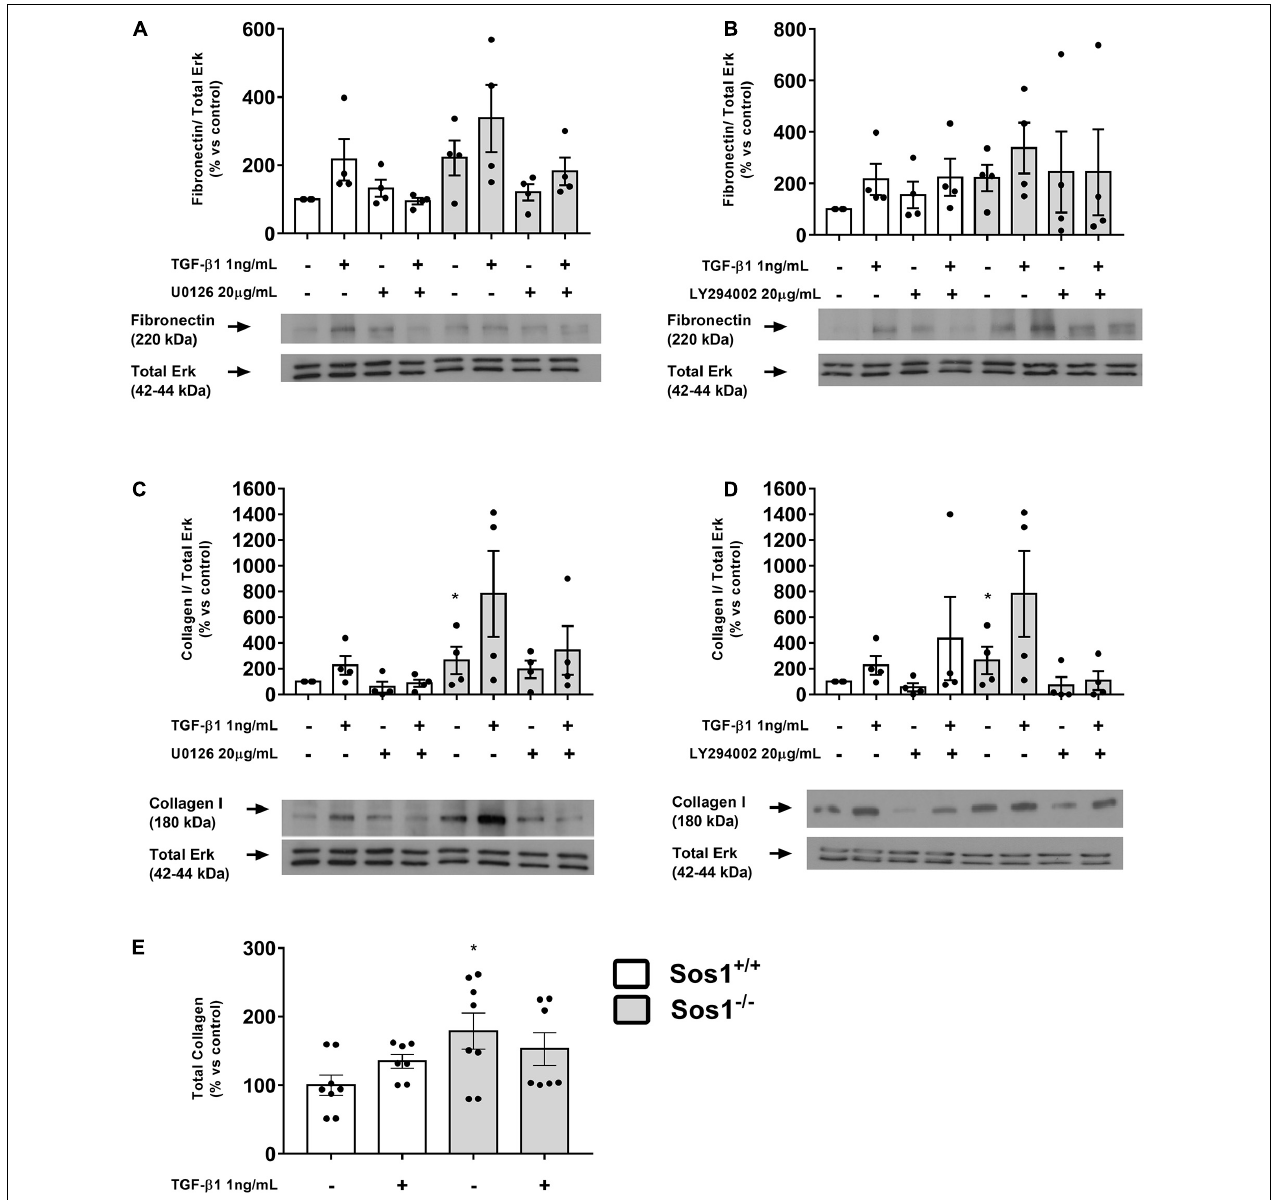
FIGURE 2 | Effect of Sos-1 deficiency and effect of MEK/Erk and PI3K/Akt inhibition on ECM proteins synthesis in fibroblasts. Fibronectin (A,B) and collagen type I (C,D) protein expression (western blot); effect of phospho-Erk inhibition with 20 µ M U0126 (A,C) and phospho-Akt inhibition with 20 µ M LY294402 (B,D) on collagen type I and fibronectin expressions evaluated by western blot; total collagen synthesis (E) . Lower panels in (A–D) show a representative blot of 4 experiments. Histograms in panel (A–D) represent the mean ± S.E.M. of the optical density of the ratio fibronectin or collagen/ERK 1/2 expression (used as loading control), expressed as percentage over basal values (Sos-1 + / + fibroblasts in basal conditions, 100%). Histograms in E represent the mean ± S.E.M. of 7-8 experiments expressed as percentage over basal values (Sos-1 + / + fibroblasts in basal conditions, 100%), performed in triplicate. Statistically significant differences: * p < 0,05 vs. Sos1 + / + in basal